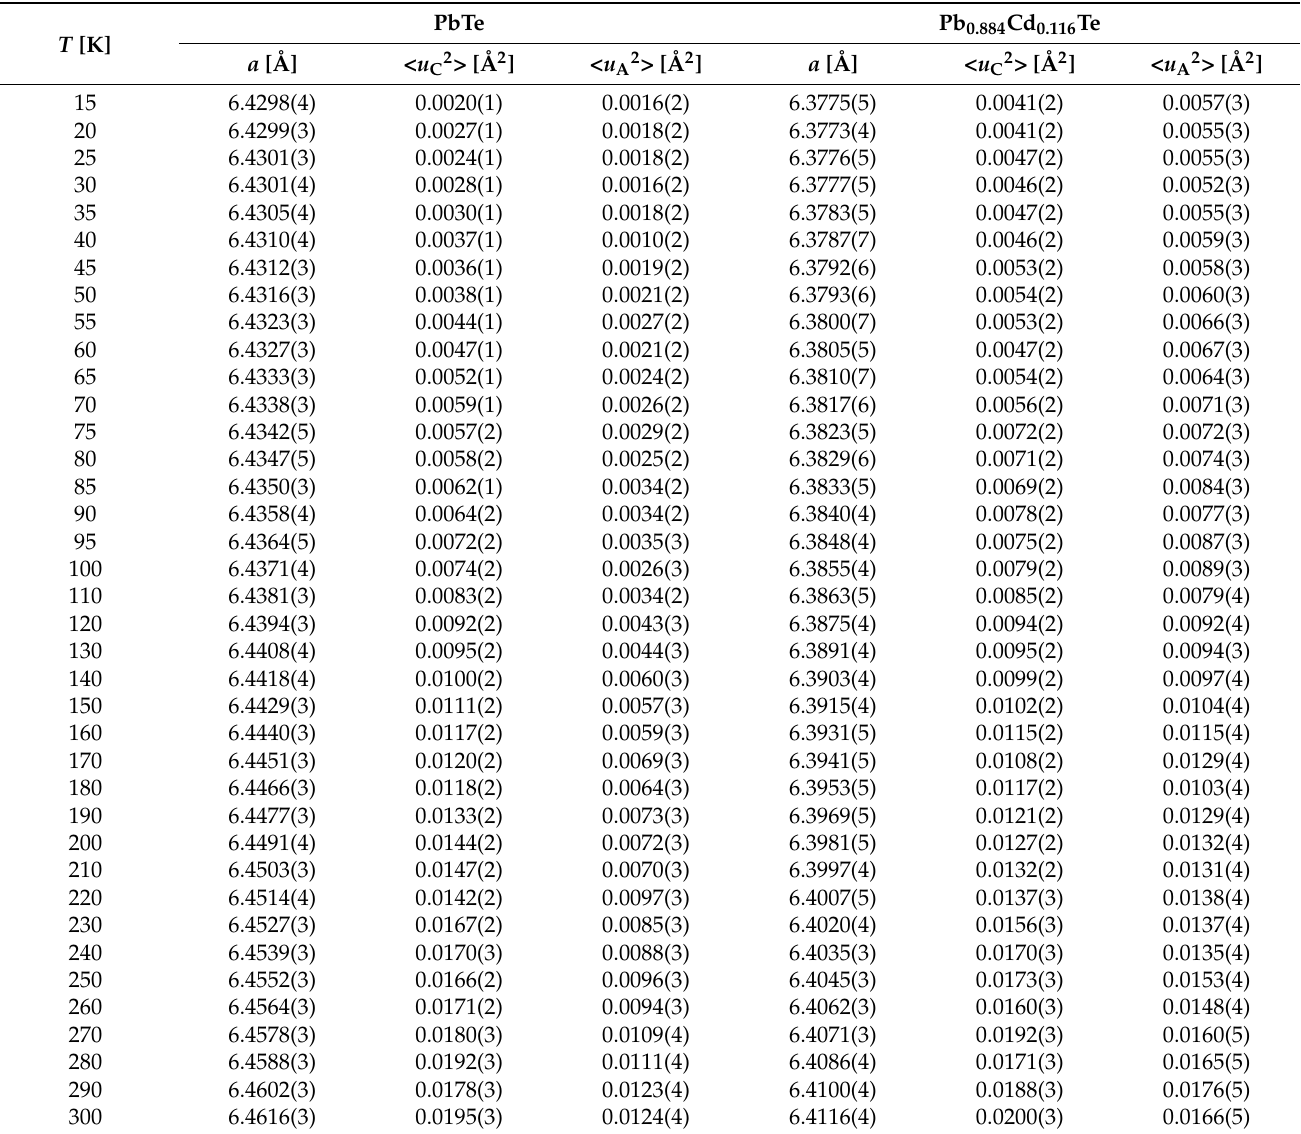
Figure A1. Rietveld refinement results for PbTe ( upper row ) and Pb 0.884 Cd 0.116 Te ( bottom row ) at 15 K and 300 K. The experimental points are indicated by dots and the calculated patterns by the solid line. The positions of Bragg reflections of the sample are indicated as short vertical bars at the bottom ( upper row ), and those of the diamond calibrant ( lower row ). The difference patterns are displayed at the bottom of each subfigure. Table A1. Present a ( T ) and < u 2 >( T ), obtained from Rietveld refinements for PbTe and Pb 0.884 Cd 0.116 Te.